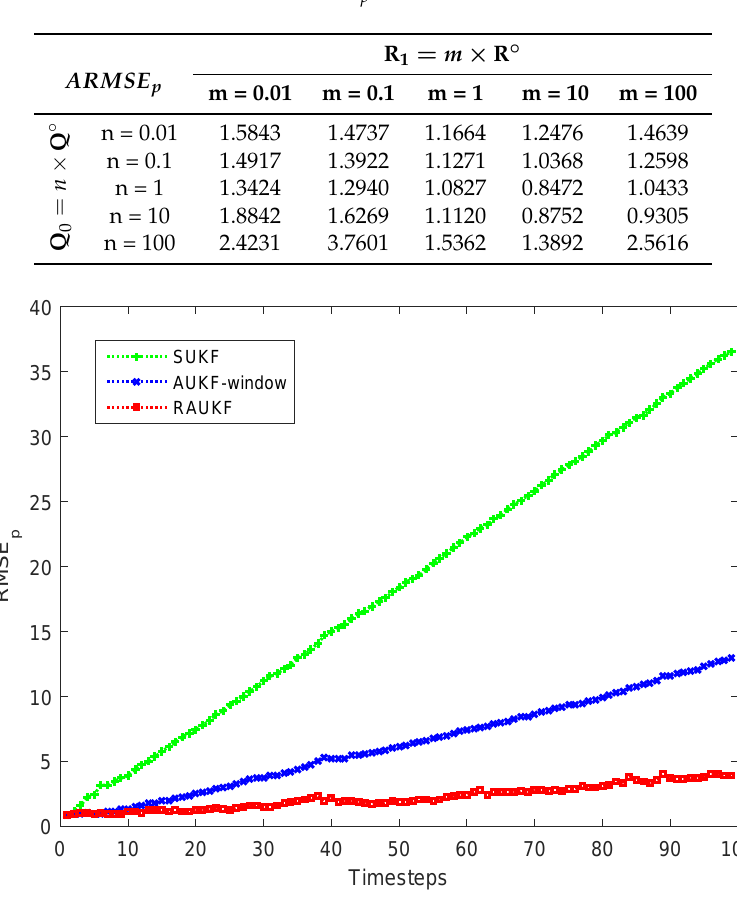
Table 3. ARMSE p results of RAUKF.